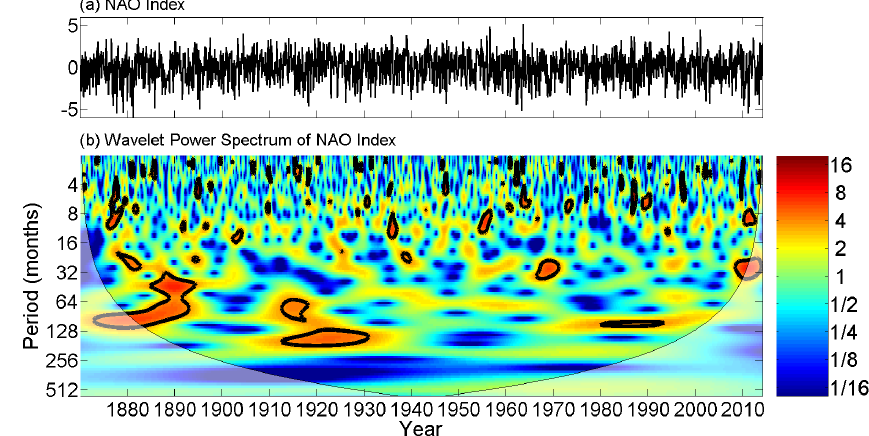
Figure 1. (a) The NAO index from 1870 to 2013. (b) The normalized wavelet power spectrum of the NAO index. Thick contours enclose regions of 5% pointwise significance. Light shading corresponds to the cone of influence, the region in which edge effects become important.